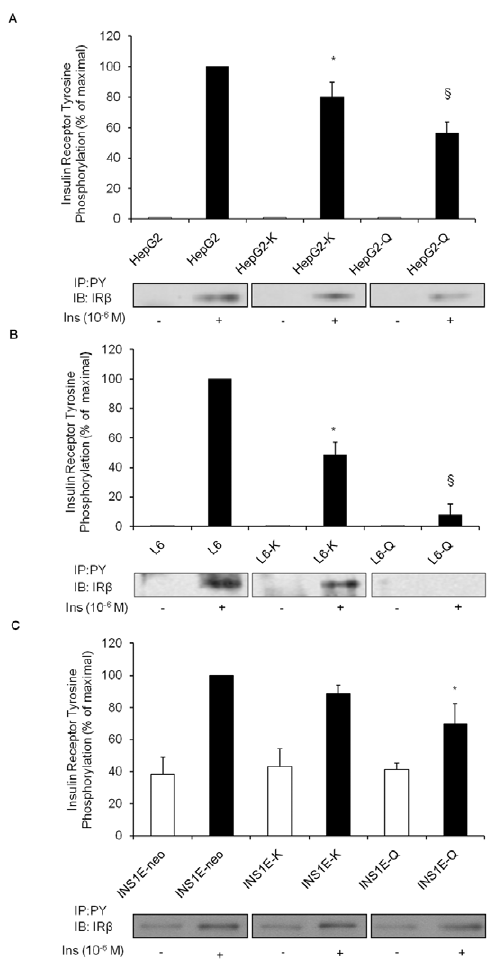
Figure 1. Studies on IR autophosphorylation in HepG2 (A), L6 (B) and INS1E (C) cells. Cells were either transfected, or not, with ENPP1 -K121 cDNA or with ENPP1 -Q121 cDNA and then stimulated with insulin as described in methods. Equal amount of protein from cell lysates was immunoprecipitated with anti-PY antibody, separated by SDS-PAGE and probed with IR-beta subunit antibody. Bars (upper panels) represent quantitative analysis of IR autophosphorylation calculated as percentage of that of stimulated untransfected cells in each experiment (mean 6 SEM), while representative immunoblots from the same experiment are shown in lower panels. ( A ) In HepG2 cells, insulin induced IR-beta subunit autophosphorylation. This effect was significantly reduced in HepG2-K (*p=0.02, fourth vs. second bar, n=3 experiments in separate times) and more profoundly in HepG2-Q ( 1 p , 0.001, sixth vs. second bar, n=3 experiments in separate times) cells. When properly tested, a progressive reduction was observed from control to HepG2-K and then HepG2-Q cells (p for trend , 0.001). ( B ) In L6 cells, insulin induced IR-beta autophosphorylation. As compared to control cells, insulin effect was significantly reduced in L6-K (*p=0.01, fourth vs. second bar, n=3 experiments in separate times) and more profoundly in L6-Q cells ( 1 p , 0.001, sixth vs. second bar, n=3 experiments in separate times). When properly tested, a progressive reduction was observed from control to L6-K and then L6-Q cells (p for trend , 0.001). ( C ) In INS1E cells, insulin induced IR-beta autopho- sphorylation. As compared to control cells, insulin effect was only slightly and not significantly reduced in INS1E-K (fourth vs. second bar, n=3 experiments in separate times) and significantly reduced in INS1E- Q cells (30% reduction *p=0.02, sixth vs. second bar, n=3 experiments in separate times). When properly tested, a progressive reduction was observed from INS1E-neo to INS1E-K and then INS1E-Q cells (p for